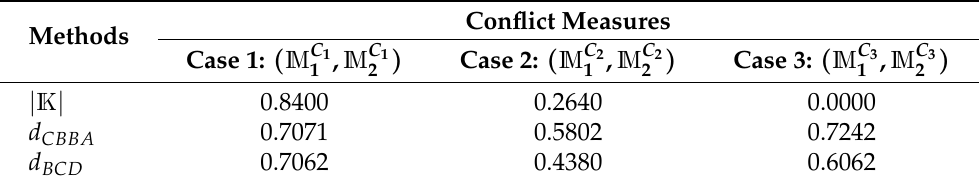
Table 2. Comparison of | K | , d CBBA , and d BCD in terms of the three cases of the complex basis belief assignments (CBBAs) in Example